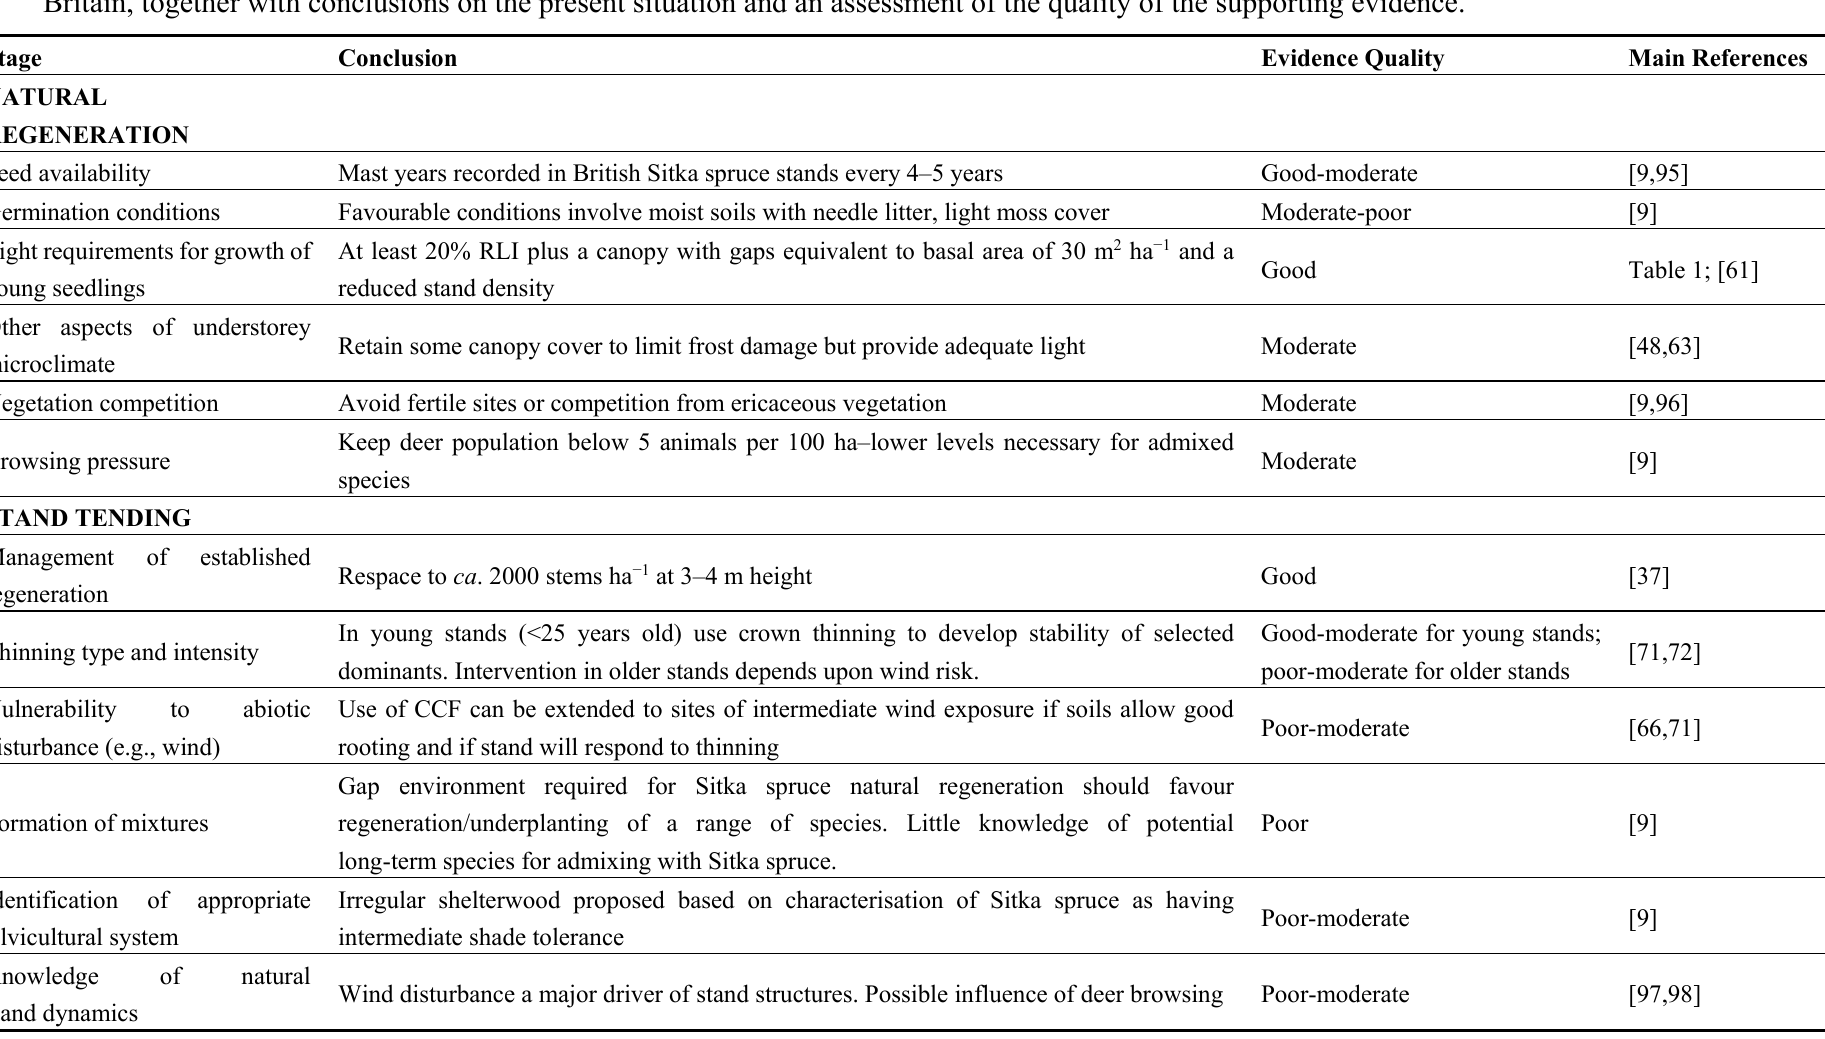
Table 6. The main stages involved in evaluation of the feasibility of introducing CCF into the management of Sitka spruce planted forests in Britain, together with conclusions on the present situation and an assessment of the quality of the supporting